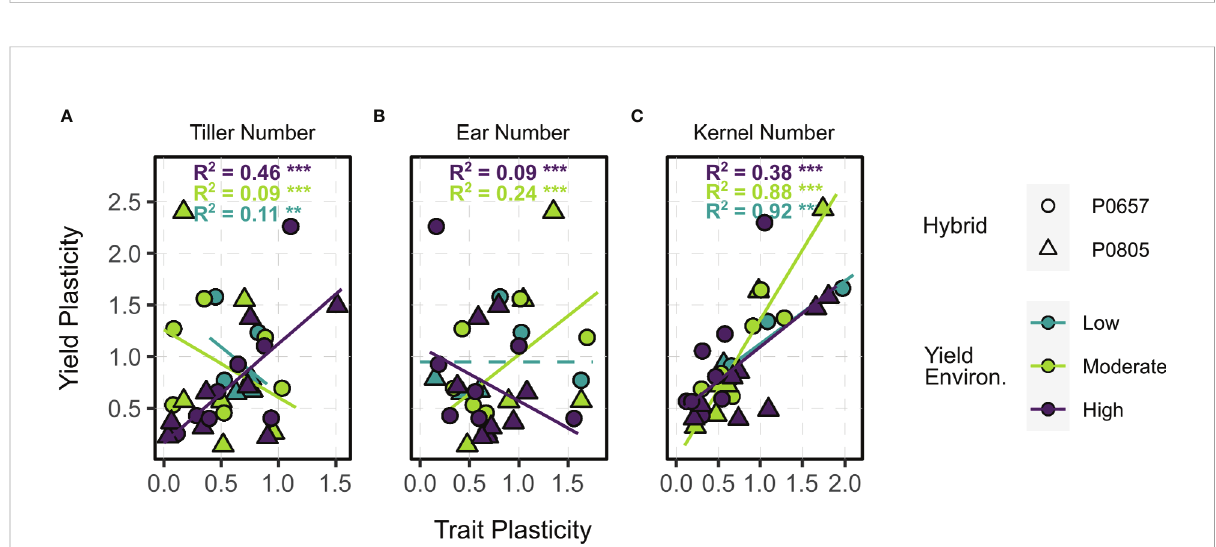
FIGURE 5 Relationships between trait plasticity ( A , tiller number; B , ear number; C , kernel number) and yield plasticity ( y ) of tillered phenotypes. Points are colored by yield environment (blue – low, green – moderate, purple – high); and shaped by hybrid (circle – P0657AM, triangle – P0805AM). Fitted lines and model metrics, when applicable, are colored by yield environment. Dashed lines indicate intercept-only models when other candidates were not signi fi cant. Signi fi cance symbols are the following: ** p ≤ 0.01, *** p ≤ 0.001.